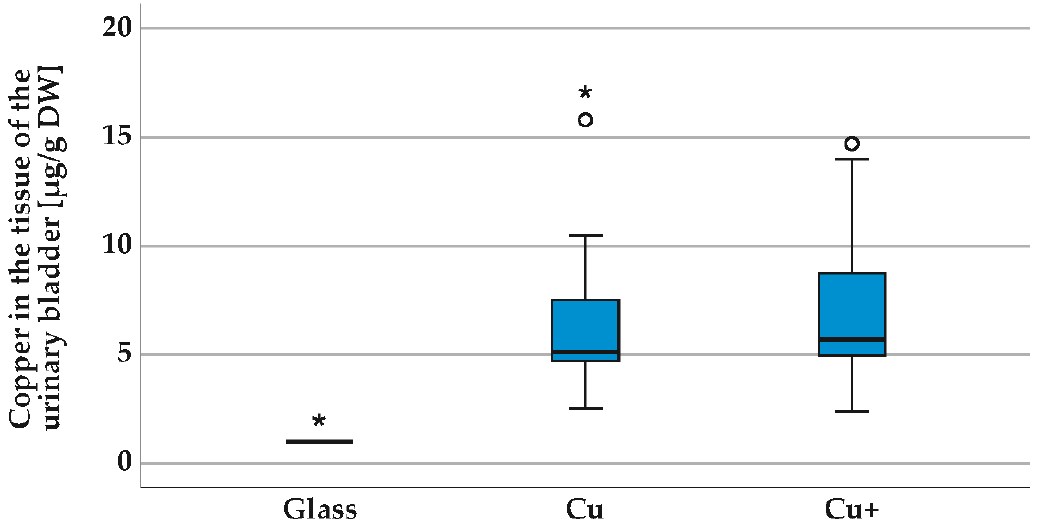
Figure 7. Copper in rat bladder tissue after sampling on day 21, (in µ g/g dry weight). Groups: glass beads (glass), copper-coated glass beads (Cu) and copper beads (Cu+), groups with n = 18. Implant diameter 2.0 mm. The copper values in the bladder tissue for the group glass beads (glass) are within the detection limit of 1 µ g/g dry weight. All measured copper values in the tissue are in the non-toxic range. Flame atomic absorption spectrometry (F-AAS, AAnalyst400, Perkin Elmer, Rodgau, Germany), median with scatter in box and whisker plot, Kruskal–Wallis test, groups glass-Cu and glass-Cu+ p < 0.001, group Cu-Cu+ p > 0.05, ◦ and * are outliers.